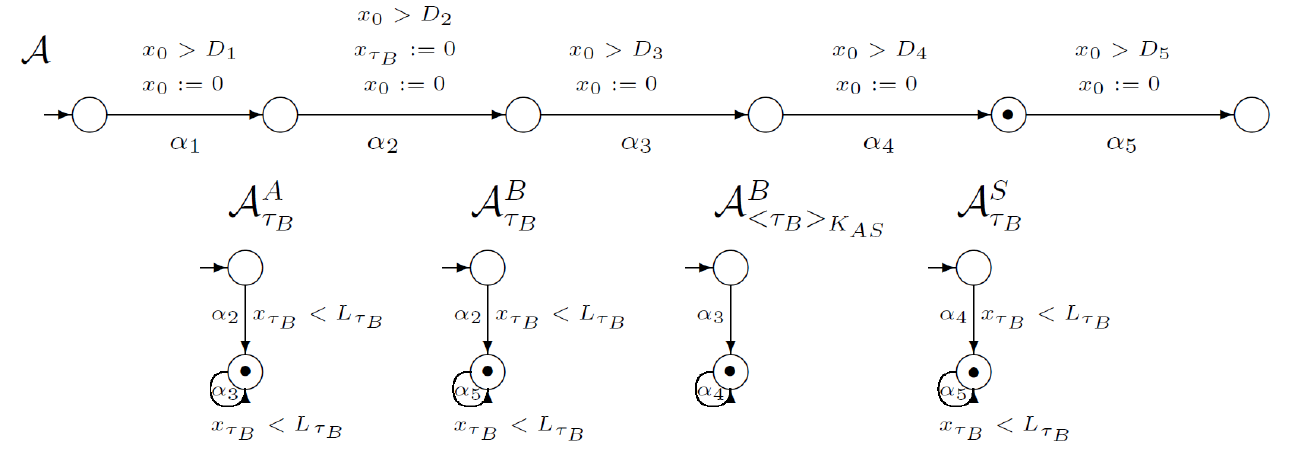
Figure 5. The fourth step of the WooLamPi protocol.